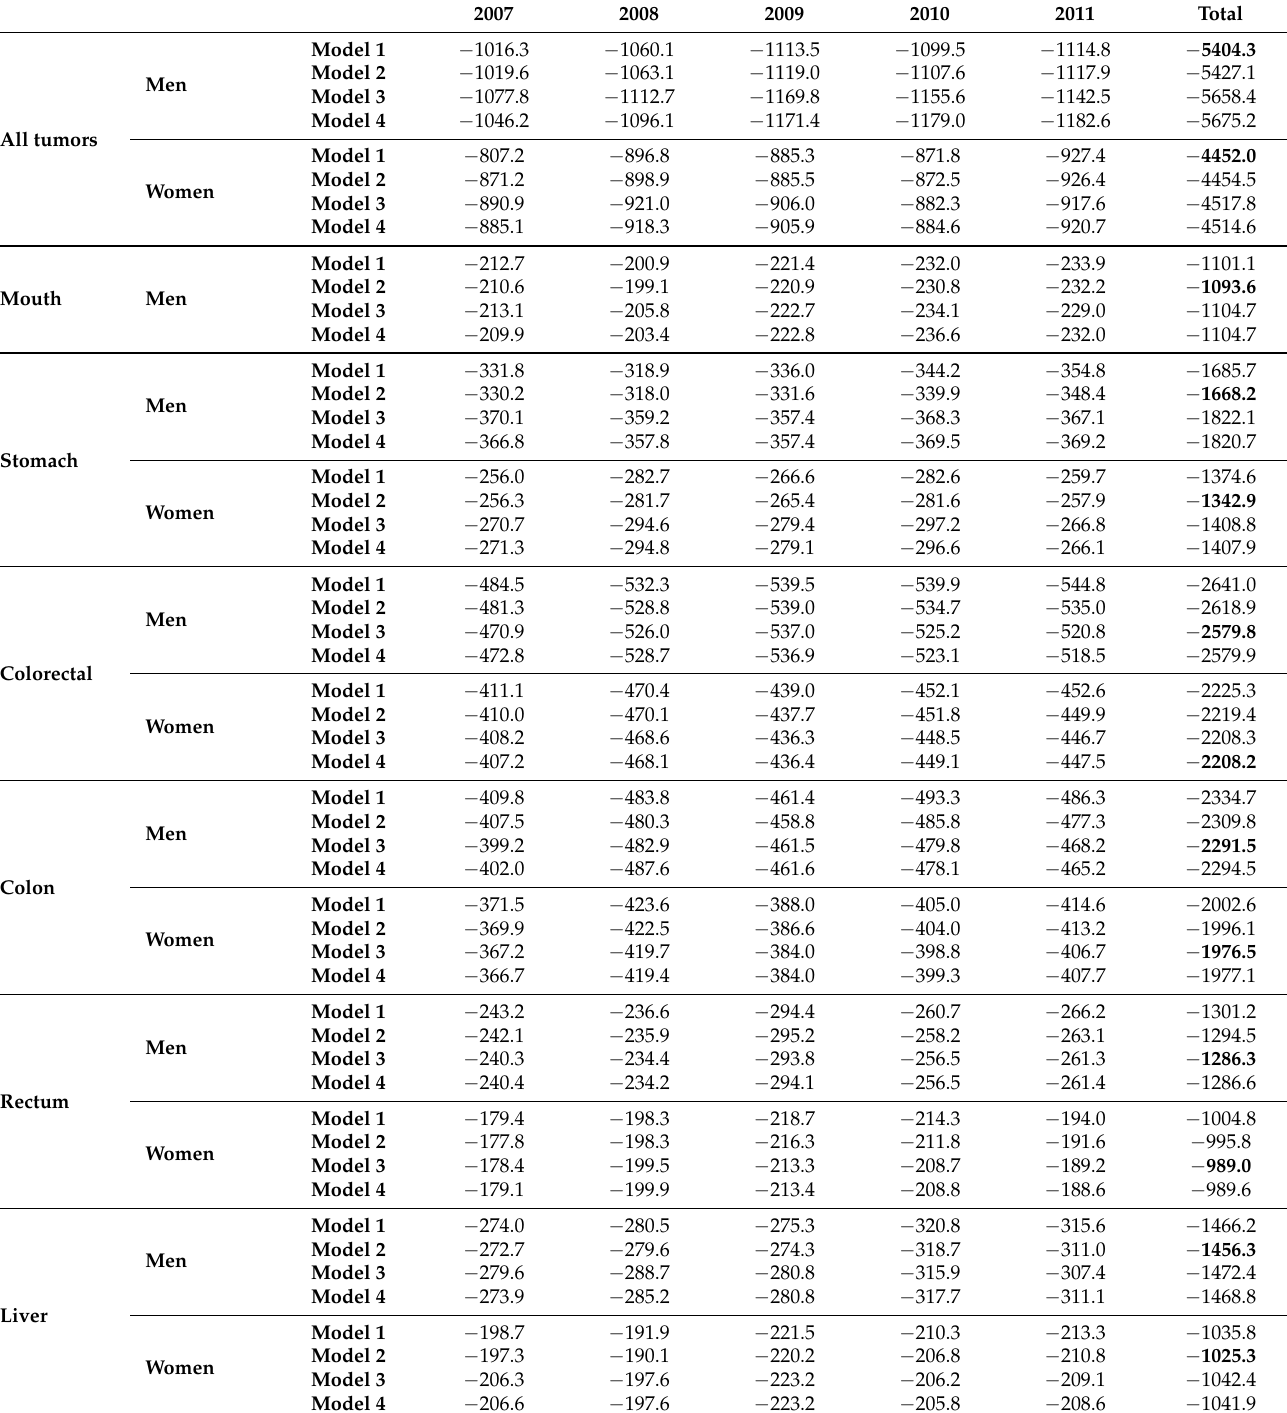
Table 4. Log predictive scores for each data set and year for the 2007–2011 period. Model 1 refers to the AR model; Model 2 refers to the new model introduced in this paper; Model 3 refers to Bernardinelli et al.’s proposal; and Model 4 refers to the model proposed by Assunção et al. In order to facilitate comparisons, the largest log predictive score in each case is highlighted in